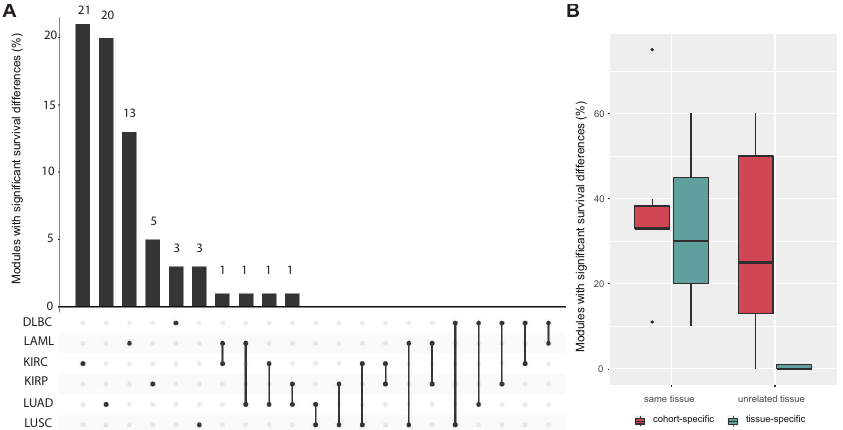
Figure 5. ( A ) Number of cohort-specific and tissue-specific regulatory modules in cross-cohort exper- iments with significant survival analysis based on clinical information. ( B ) Box plot demonstrating the percentage of tissue- and cohort-specific regulatory modules with significant survival analysis in experiments with cohorts from the same tissue and unrelated tissues.